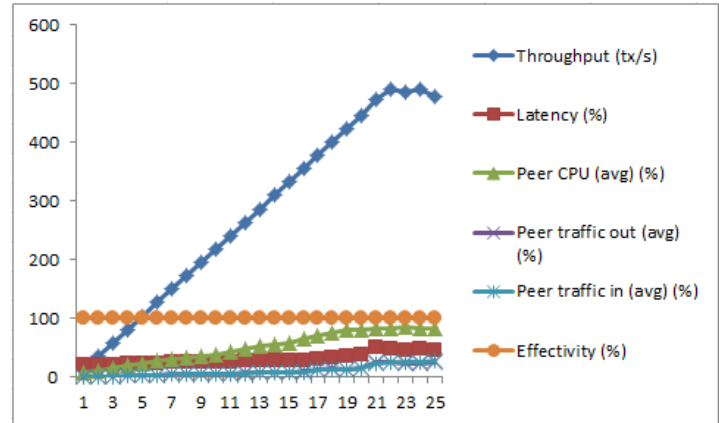
Figure 20. Benchmarking ramp